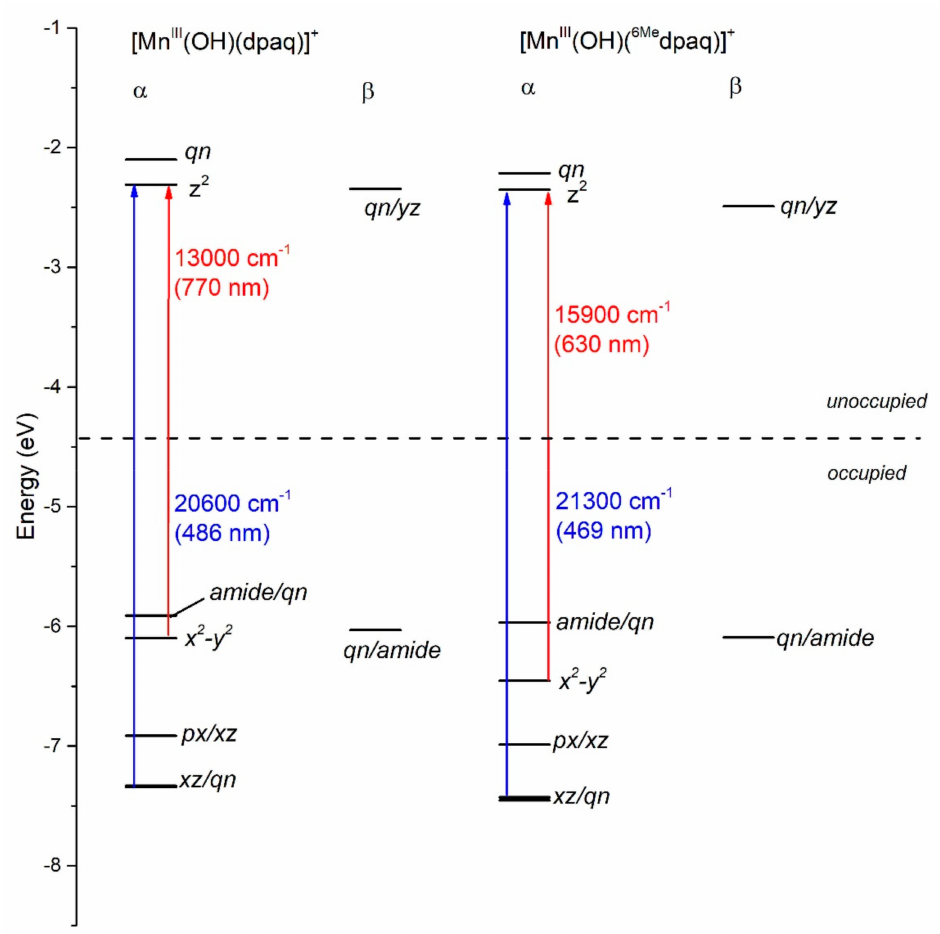
Figure 3. MO energy level diagram for [Mn III (OH)(dpaq)] + and [Mn III (OH)( 6Me dpaq)] + based on the Kohn-Sham orbitals from DFT calculations. α and β refer to spin-up and spin-down MOs,